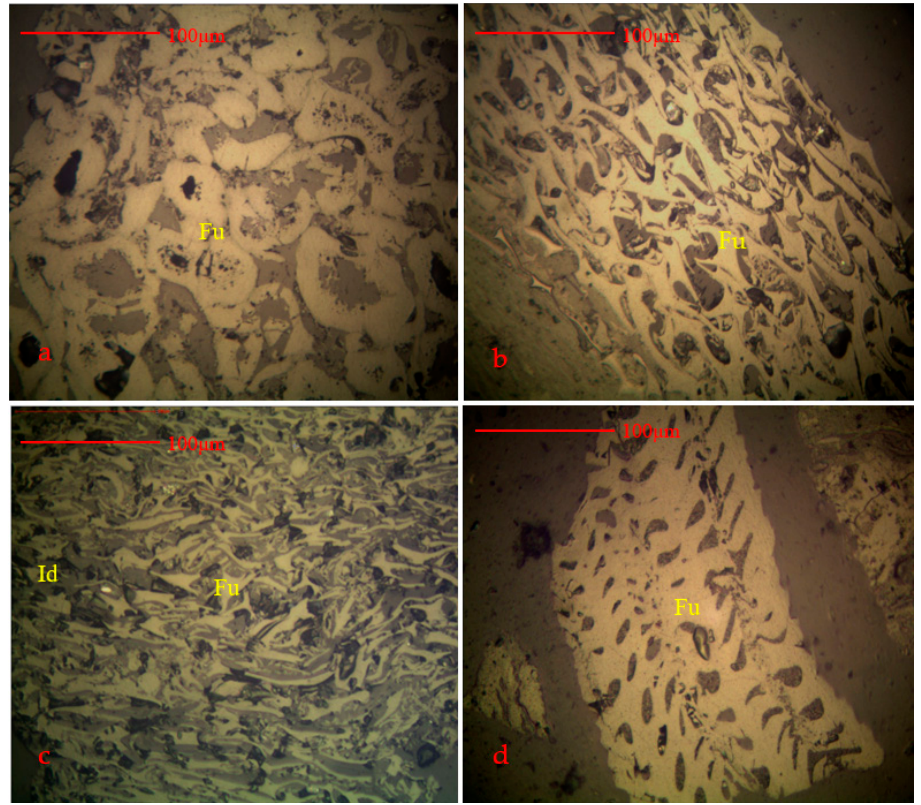
Figure 3. Inertinite macerals in coal under optical microscope with reflected white light and immersed in oil: ( a ) fuginite (Fu), sample 6-8, ( b ) fusinite, sample 4-2, ( c ) fusinite and inertodetrinite (Id), sample 4-1, and ( d ) fusinite with cell structure, sample 6-10.